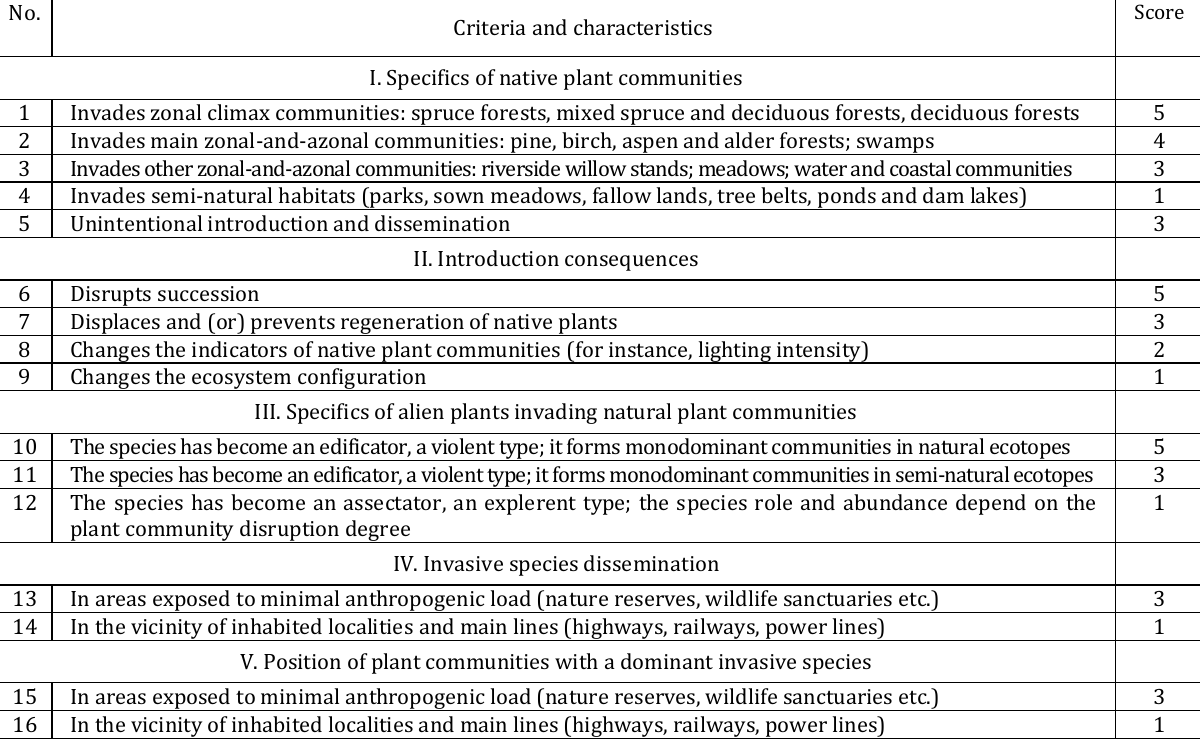
Table 1. Scale for including invasive species into the transformer category (acc. to: Panasenko, 2013, revised) No. Criteria and